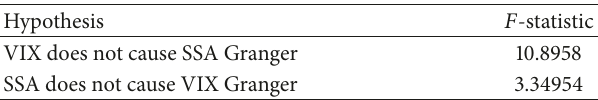
Table 6: Extreme risk fear and VIX causality test in